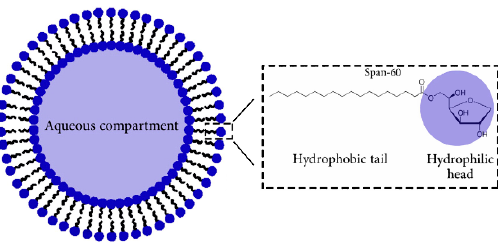
Figure 4. Schematic representation of niosome prepared by sorbitan monostearate (Span-60). Redrawn from reference [176]. Copyright 2014 Elsevier